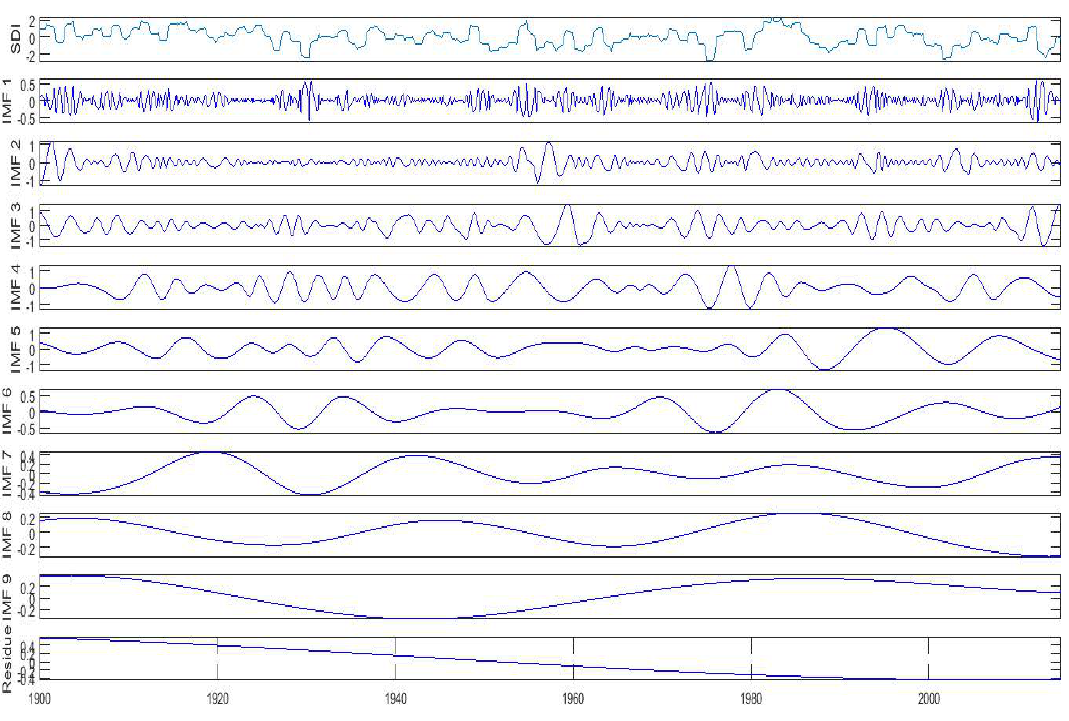
Figure 5. Decomposition using